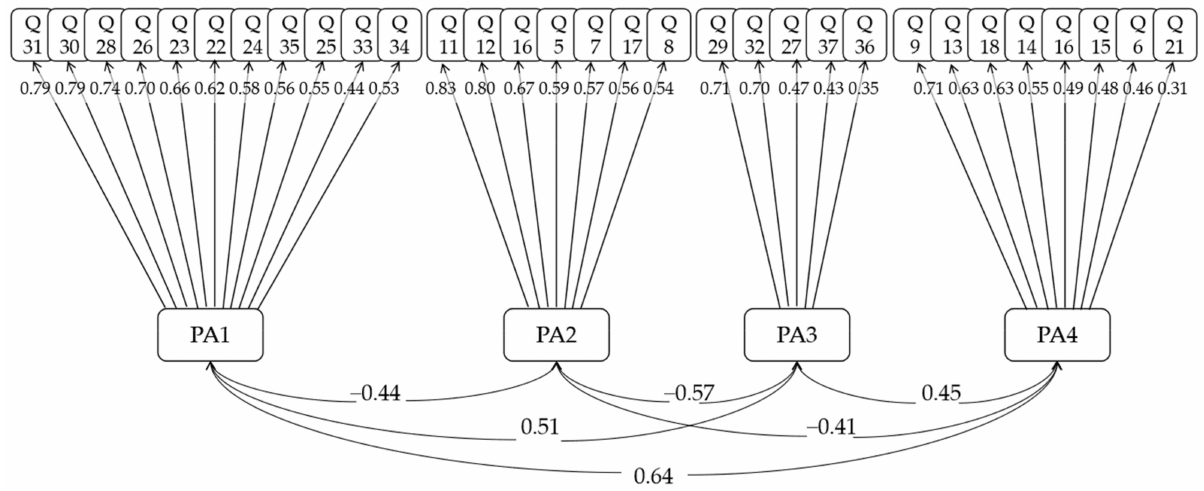
Figure 2. Factor analysis of the